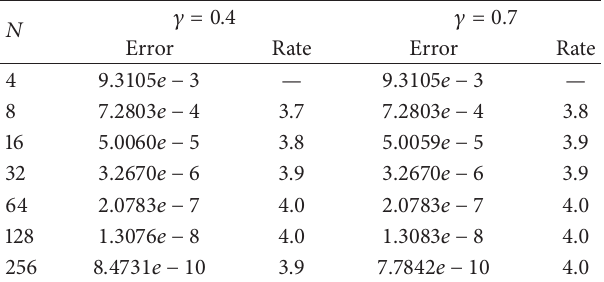
Table 3: Rate for space for 𝑔(𝑥) = 𝑥 𝜇 1 − 𝑥 𝜇 2 with 𝜇 1 = 7/2 , 𝜇 2 = 7/3 for Example 7 using 3rd-order FEM.